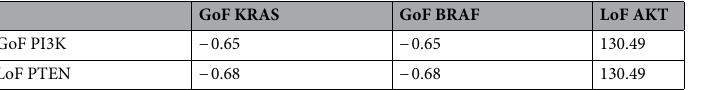
Table 2. The relative difference δ p 53 of the equilibrium concentrations of p53 induced by pairs of simultaneous mutations. Each element of the table shows the value of δ p 53 obtained when the mutations reported in the corresponding row and column are incorporated in the